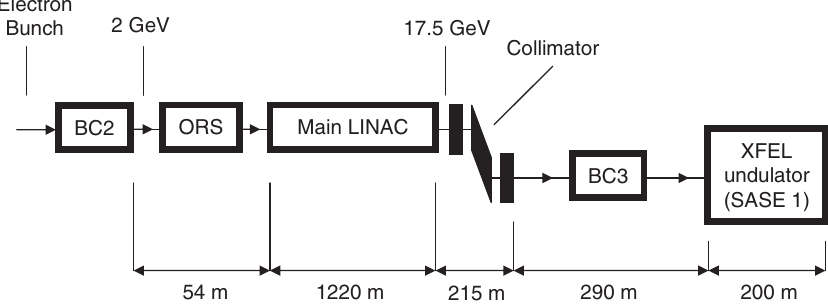
FIG. 4. Possible realization of the stabilization scheme at the European XFEL.